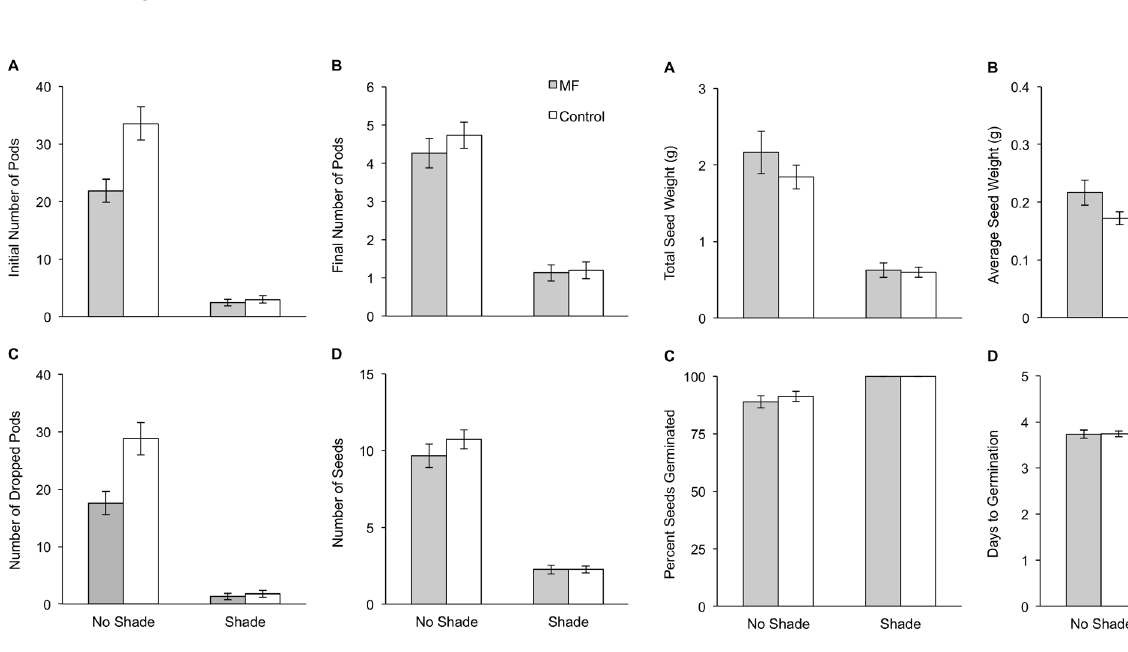
Fig. 3: Effects of mycorrhizal fungi and light availability on seed production. Number of initial pods per plant (a) was determined 6 weeks after planting. Final number of pods (b), dropped pods (c), and total seed production per plant (d) was determined at the end of the cultivation period. MF = Mycorrhizal Fungi; Values shown are means + SE; n = 15 plants per treatment